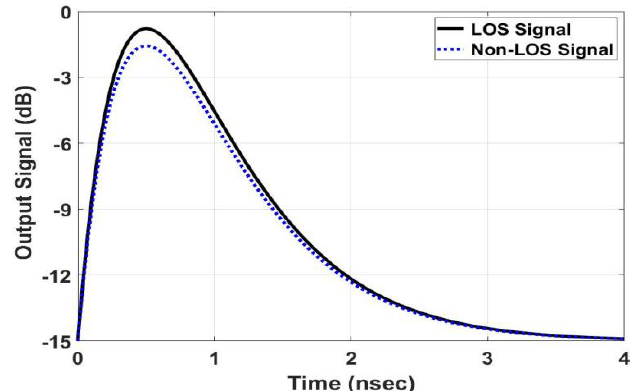
Figure 5. Estimated channel response for the LoS signal and strongly reflected (non-LOS) version of the same signal.